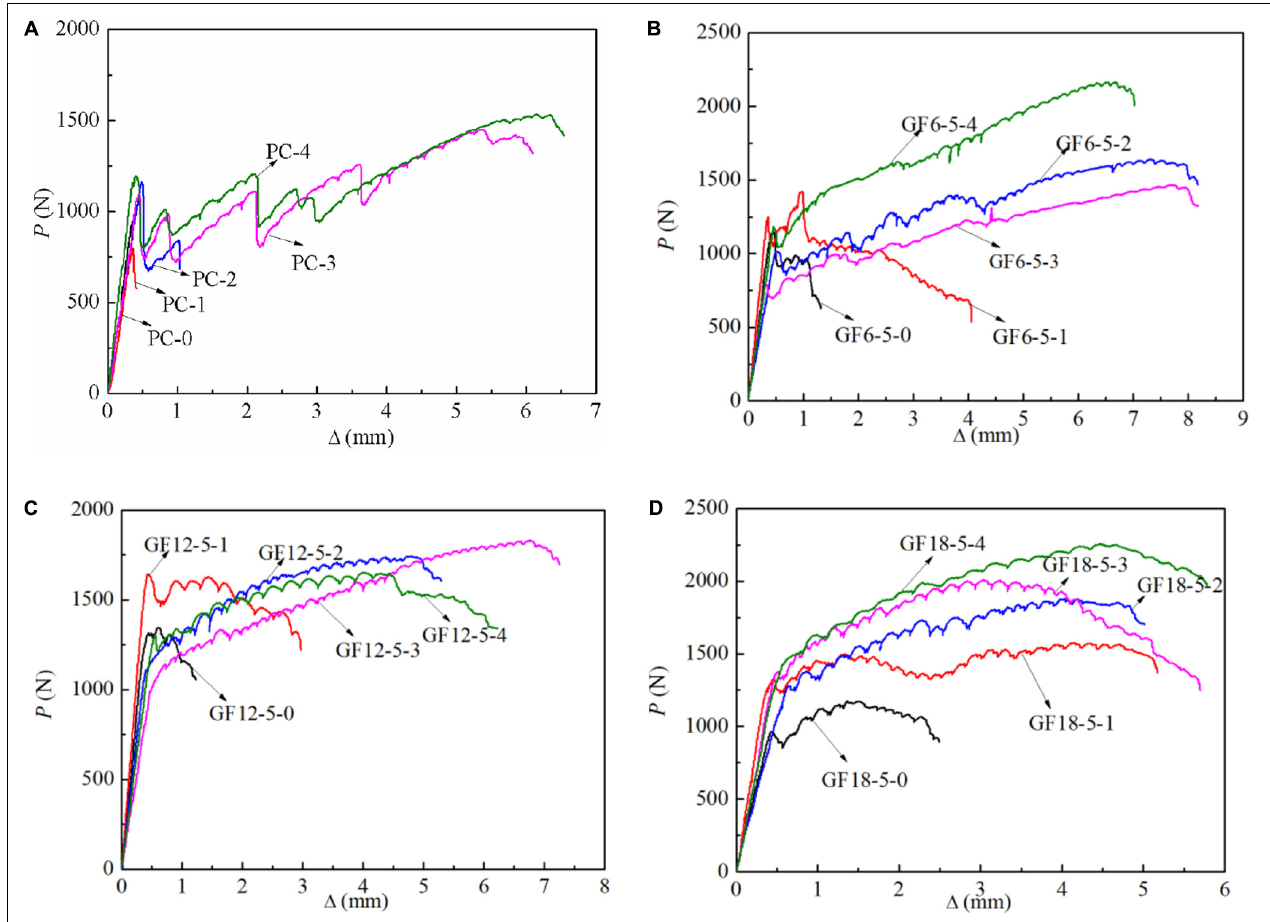
FIGURE 7 | Relationship of load-deformation curves and the number of textile layers. (A) PC, (B) GF6-5, (C) GF12-5, and (D)